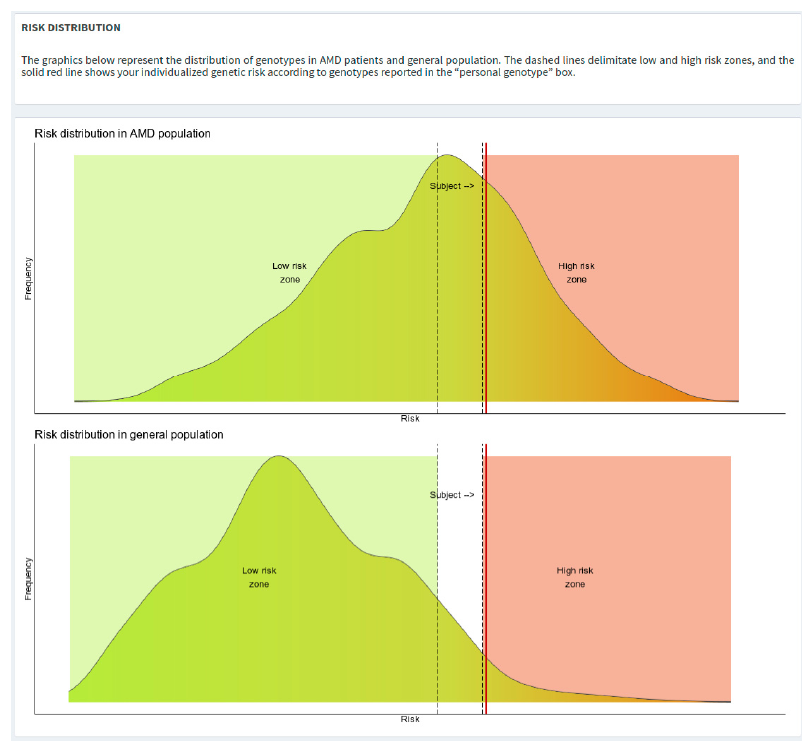
Figure 4. Risk distribution plots with low- and high-risk zones highlighted. After the execution of the calculation, a red vertical line will be plotted showing the risk of the subject of interest.